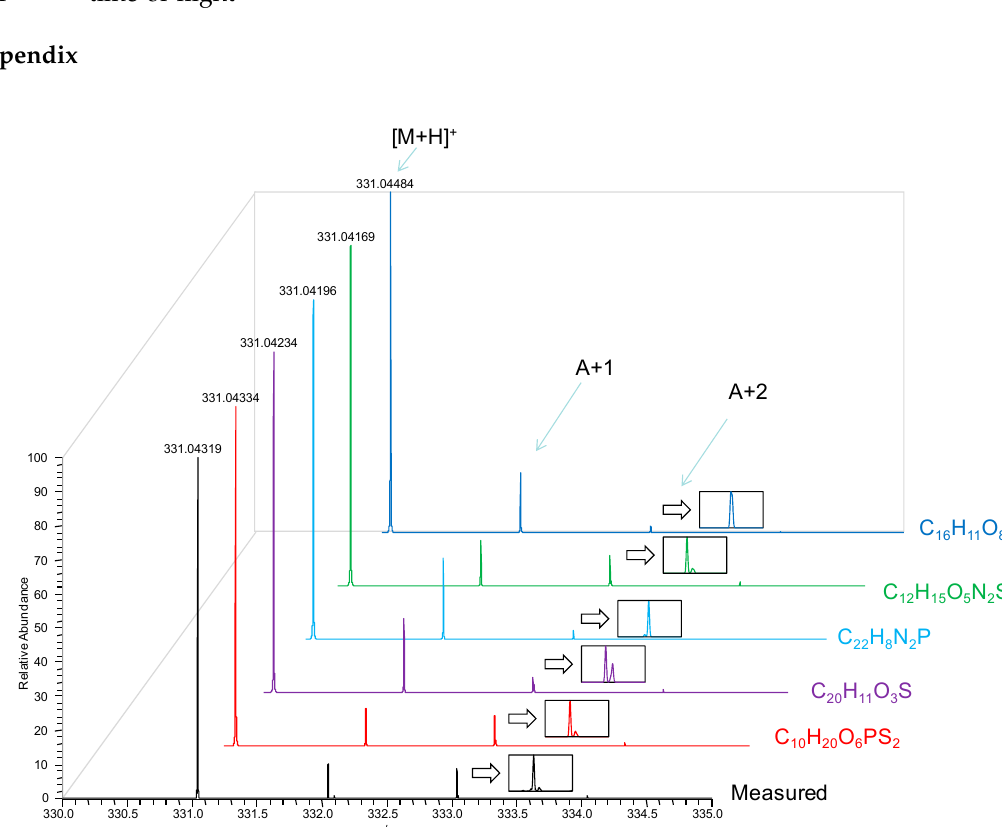
Figure A1. Relative abundances of the measured A+1 and A+2 isotope peaks (bottom trace), as well as isotopic fine structure of the A+2 isotope peak (inset over the bottom trace labeled “Measured”) for the protonated analyte also affords the best match with those predicted for C 10 H 20 O 6 PS 2 . The isotope peak abundances and isotopic fine structures for the indicated elemental compositions listed in Table 1 a (colored traces and insets, respectively) were predicted presuming M / Δ M of 120,000, FWHM.